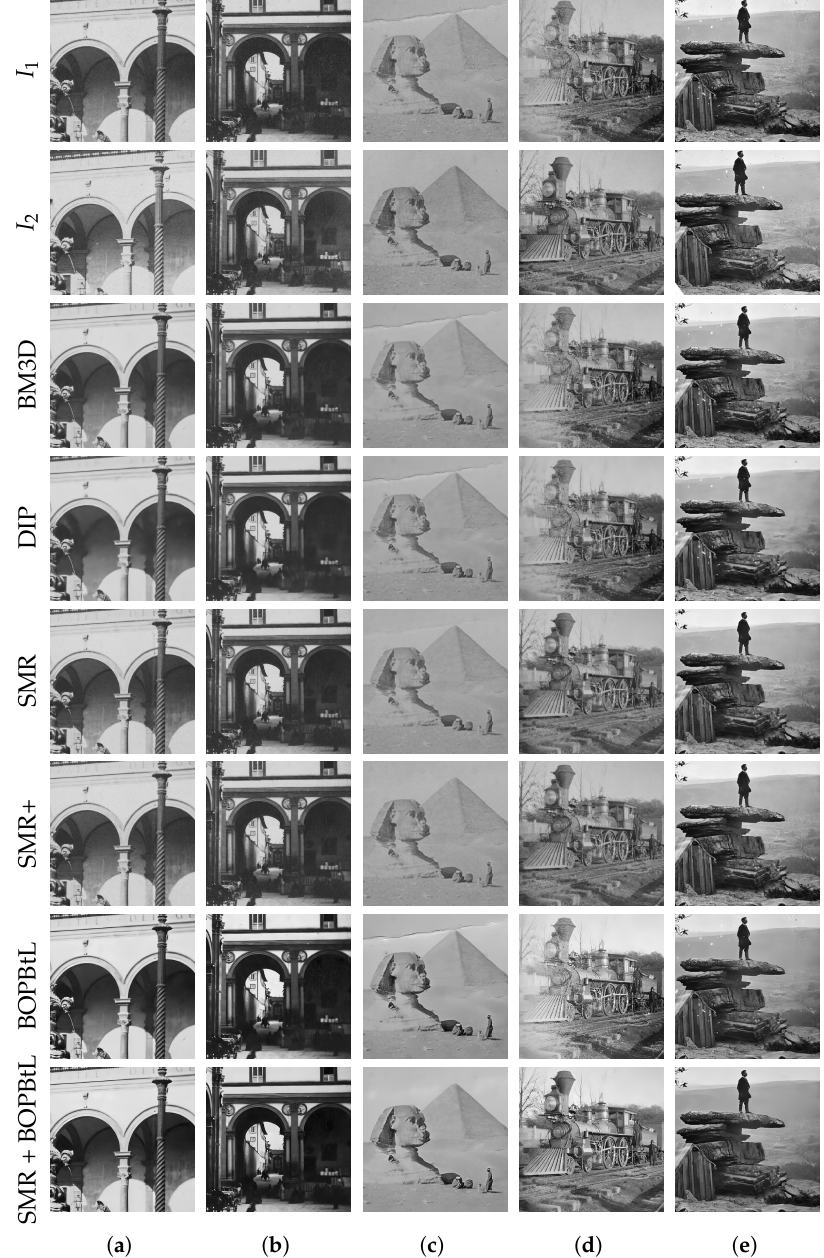
Figure 10. Qualitative visual comparison of the methods under test. Best viewed in color. The reader is invited to zoom in on the electronic version of the manuscript in order to better appreciate the